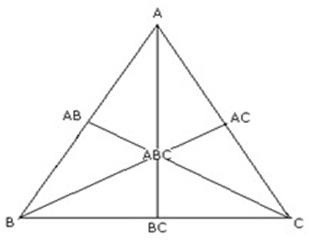
Equilateral triangle representing simplex lattice design for 3 components (A, B and C).